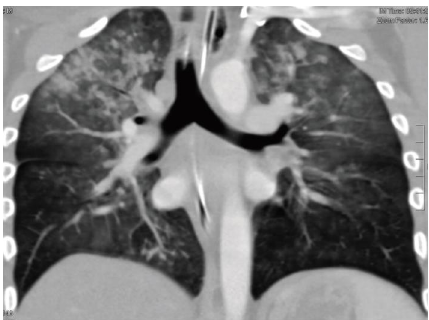
Figure 1: Coronal view of CT chest scan showing difuse alveolar ground-glass and nodular opacities prior to initiation of diuretic therapy.